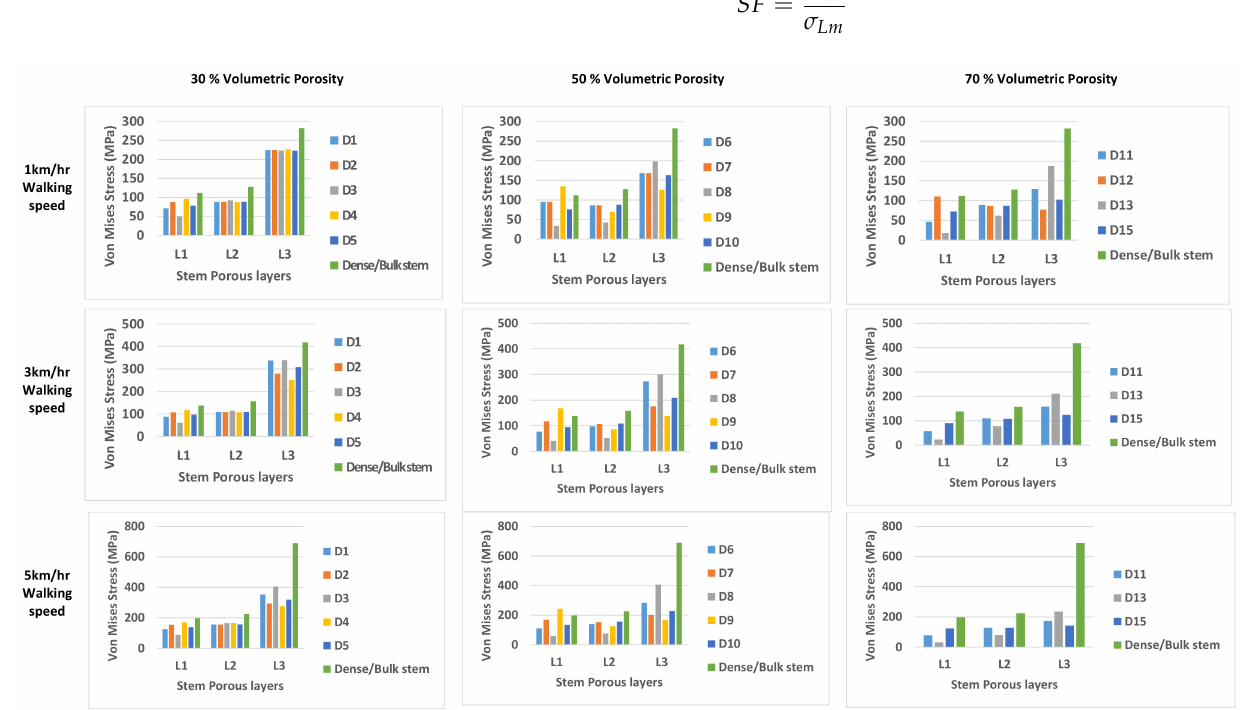
between the relevant stem layer yield strength ( Y sl ) and the maximum stress value of that layer ( σ Lm ) based on Equation (8):